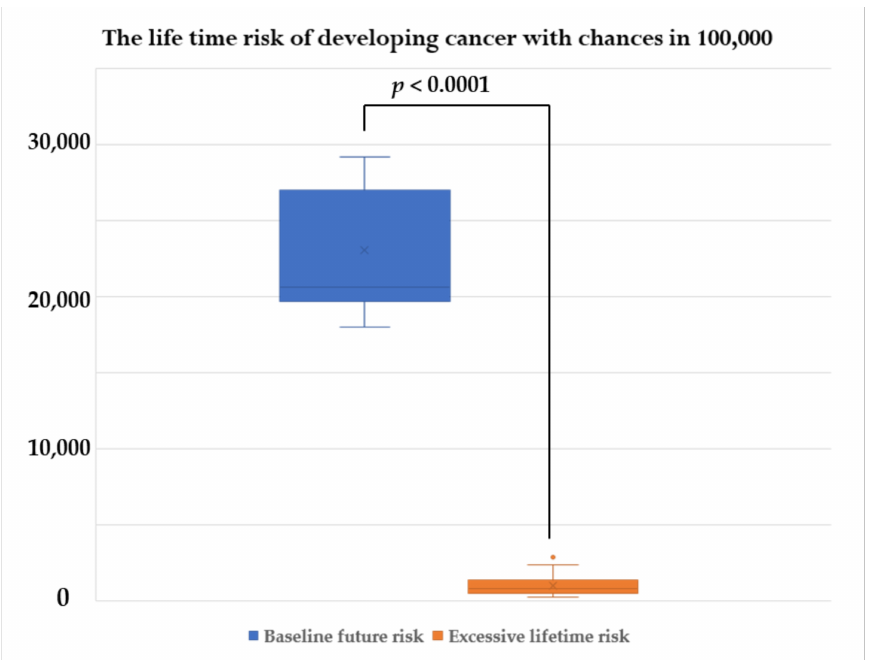
Figure 5. Comparison between the lifetime risk of developing cancer with chances in 100,000 between baseline future risk and the excessive lifetime risk of developing